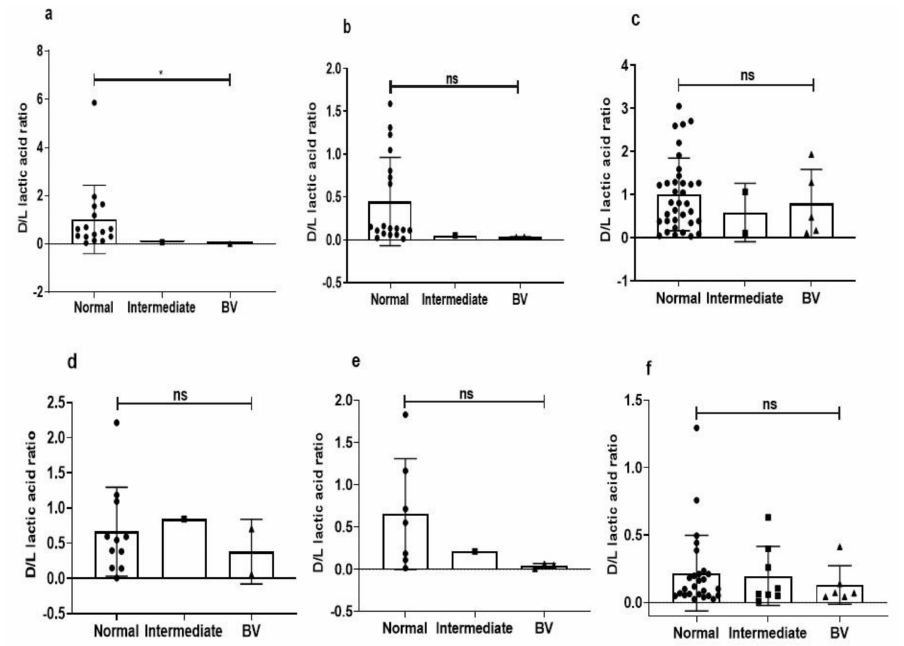
Figure 4. d - / l - lactic ratios of ( a ) L. jensenii , ( b ) L. gasseri , ( c ) L. reuteri , ( d ) L. salivarius , ( e ) L. johnsonii , ( f ) L. rhamnosus from normal, intermediate and bacterial vaginosis (BV) microbiota. Data are represented as mean ± SD. ns = not significant and * p < 0.05, indicates statistical significance after performing the Kruskal–Wallis